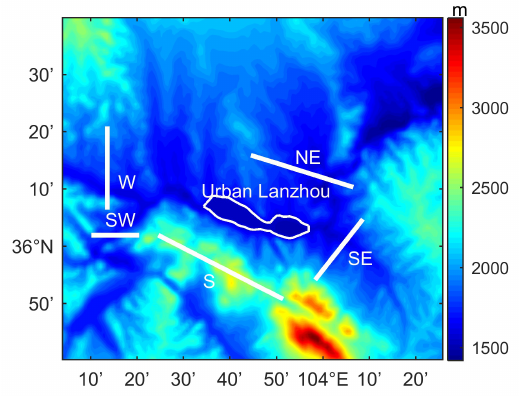
Figure 3. The transport trajectories of particles emitted in the east and west valleys at ( a , b ) 14:00 BT and ( c , d ) 20:00 BT during six winters from 2002 to 2007. The red points represent the emission location, emitted at 2 m above ground level. The shading represents the terrain.